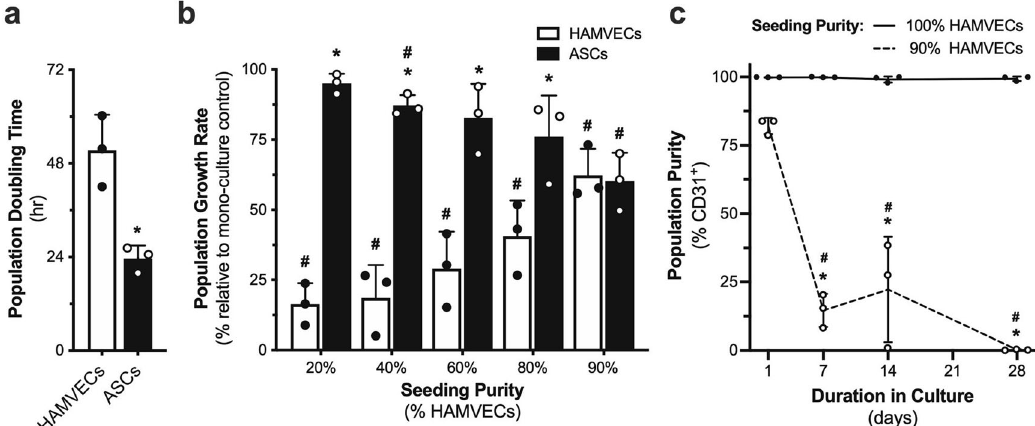
Fig. 5 Heterotypic cell – cell interactions modulate the overgrowth of human adipose tissue-derived microvascular endothelial cells (HAMVECs) by adipose tissue-derived stromal/stem cells (ASCs). a Population doubling times of HAMVECs and ASCs, determined from their exponential growth phase observed over 7 days of culture. * p < 0.05 compared with HAMVECs. b Effect of seeding purity on the population growth rates of HAMVECs and ASCs, observed over 4 days of culture. * p < 0.05 compared with HAMVECs; # p < 0.05 compared with 100%. c Effect of seeding purity on the composition of cultures maintained at con fl uence for up to 28 days. * p < 0.05 compared with 100% seeding purity at respective time-point; # p < 0.05 compared with purity at day 1. Values represent mean ± standard deviation. All experiments were performed in biological triplicate, using cells derived from three different donors ( n = 3 biologically independent samples).